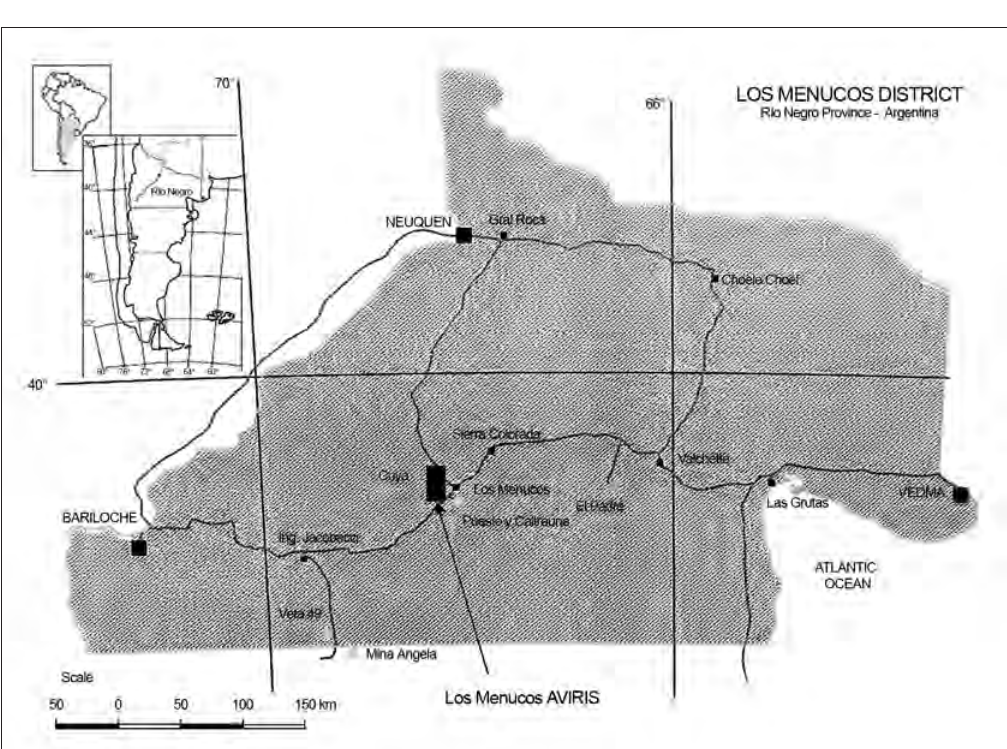
Fig. 1. Los Menucos, Argentina Site Location in Rio Negro province, Argentina. Black box marks approximate extent of AVIRIS survey conducted during February